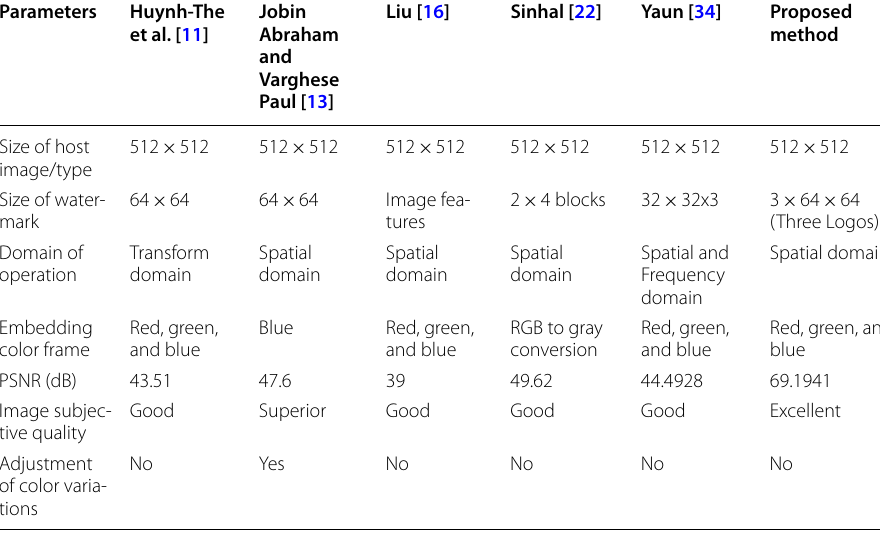
Table 7 Comparison of color images with the existing methods